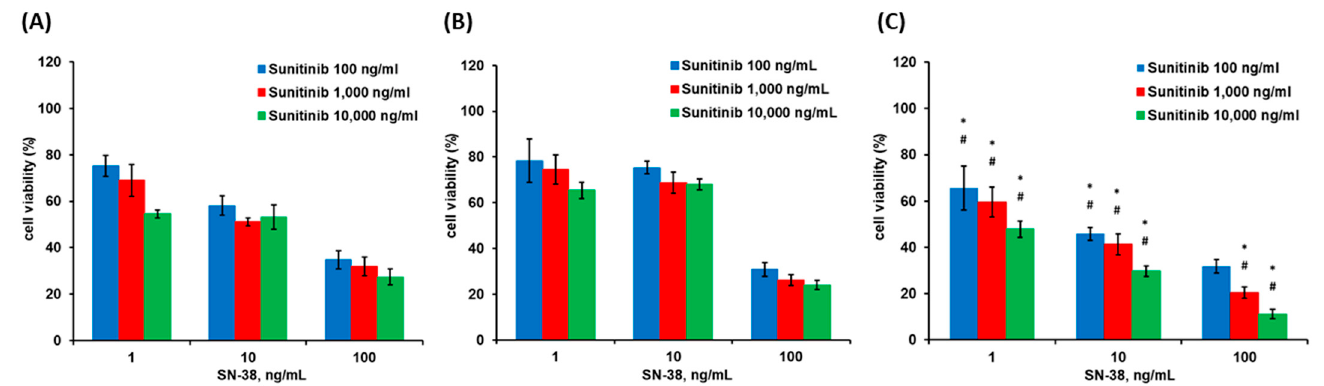
Figure 2. Cell viability at 72 h after treatment with SN-38/Sunitinib in SW-620 ( A ), HT-29 ( B ) and HCT-116 ( C ) cells. The data represent mean ± standard deviation. * means were significantly different from SW-620 ( p < 0.05). # means were significantly different from HT-29 ( p < 0.05).